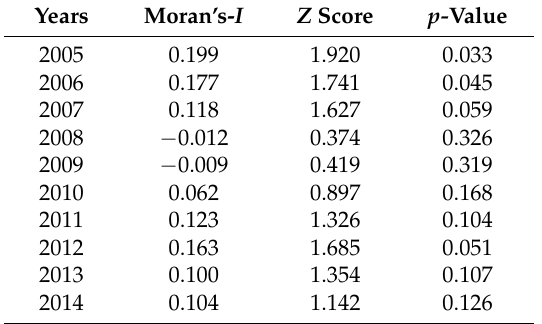
Table 2. Global spatial autocorrelation analysis of TB incidence in Beijing,